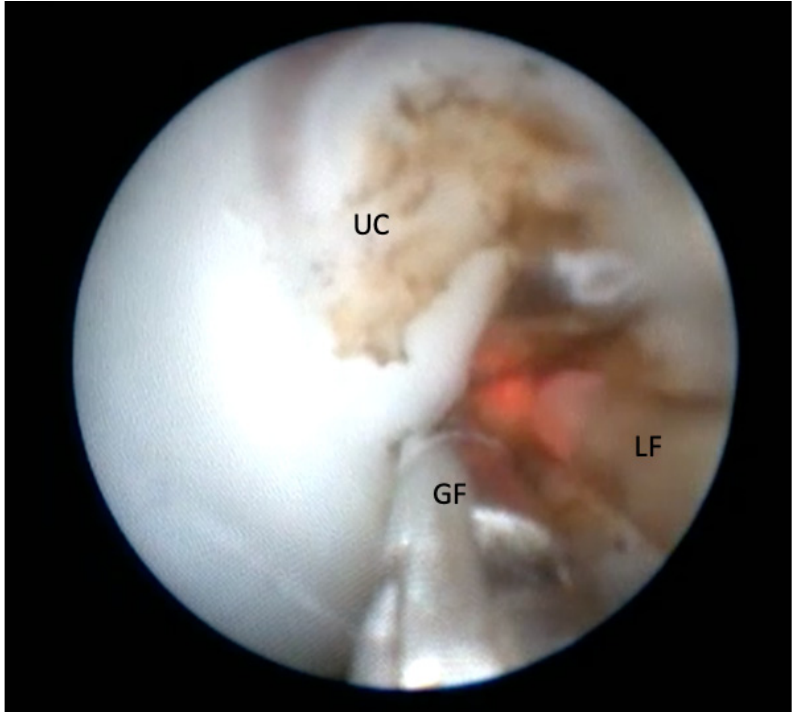
Figure 2. Dissection of the coagulated umbilical cord (UC) with a 3 Charr. grasping forceps (GF) and a bare laser fiber (LF).